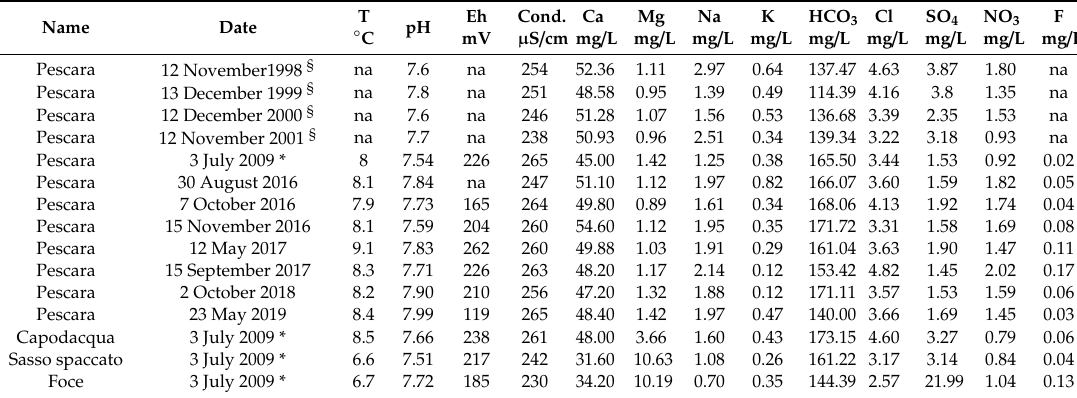
Table 3. Chemical data of Pescara di Arquata spring before and after the seismic sequence and compared with that of springs located nearby.